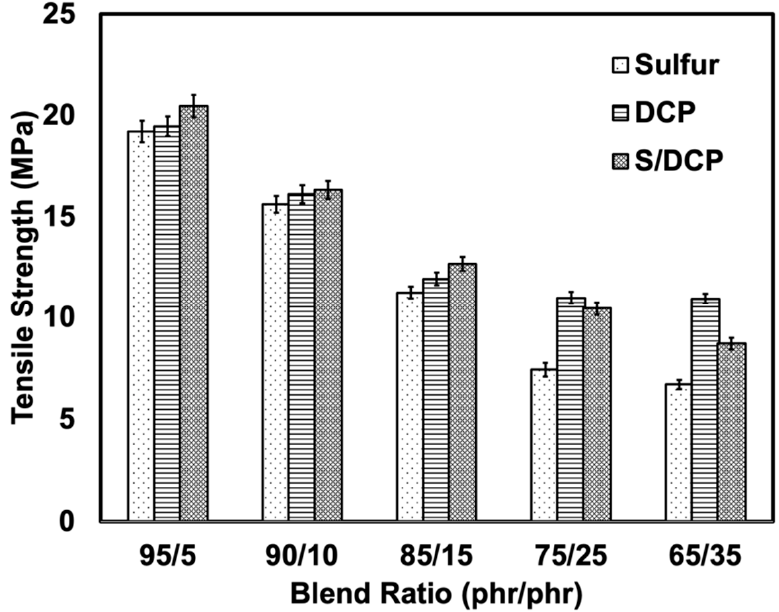
Figure 2. Tensile strength of NR/r-NBR blends prepared with various crosslinking systems.